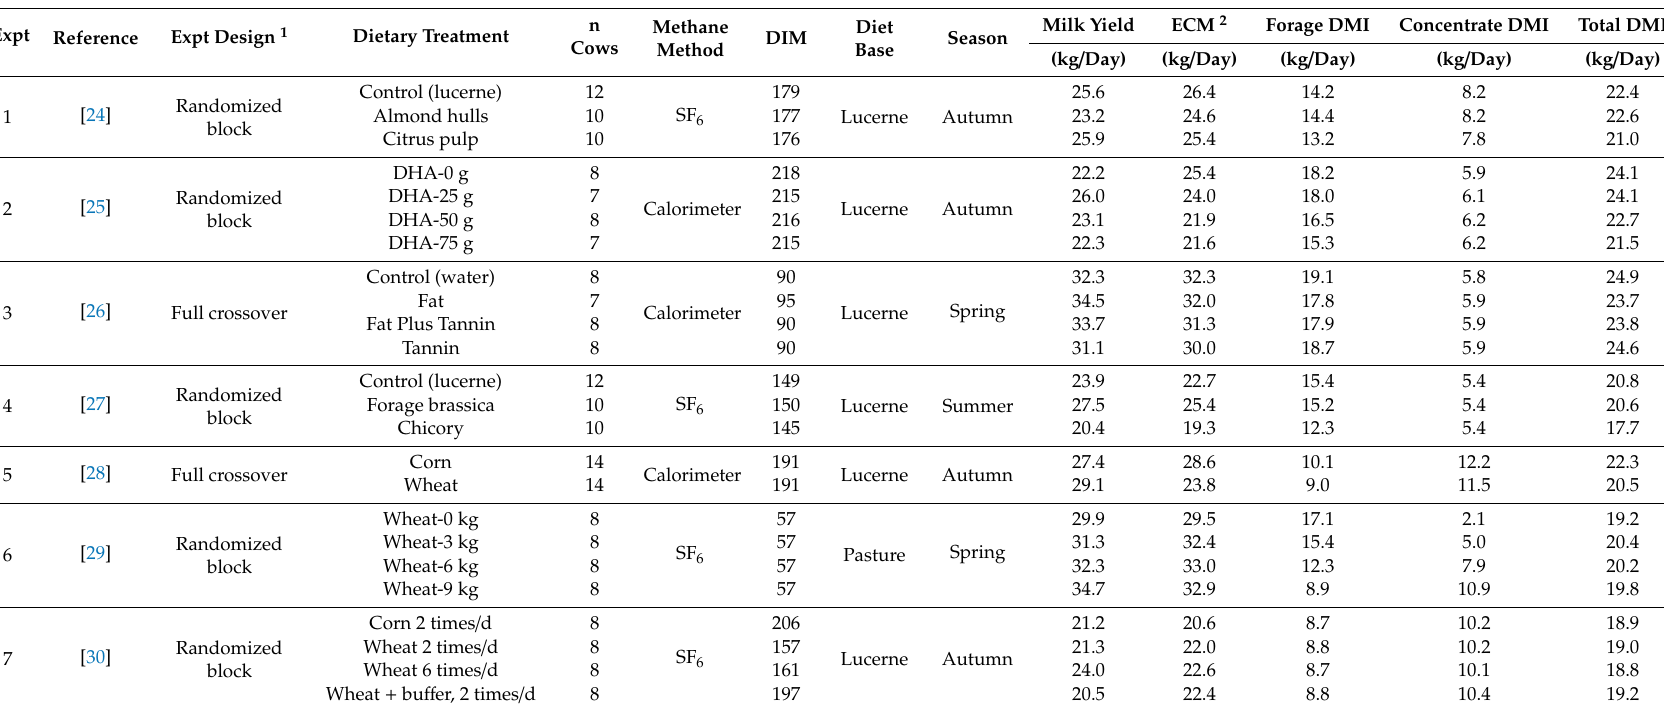
Table 2. Details of the seven experiments and means for 24 treatments from which individual cow data were used to develop the prediction